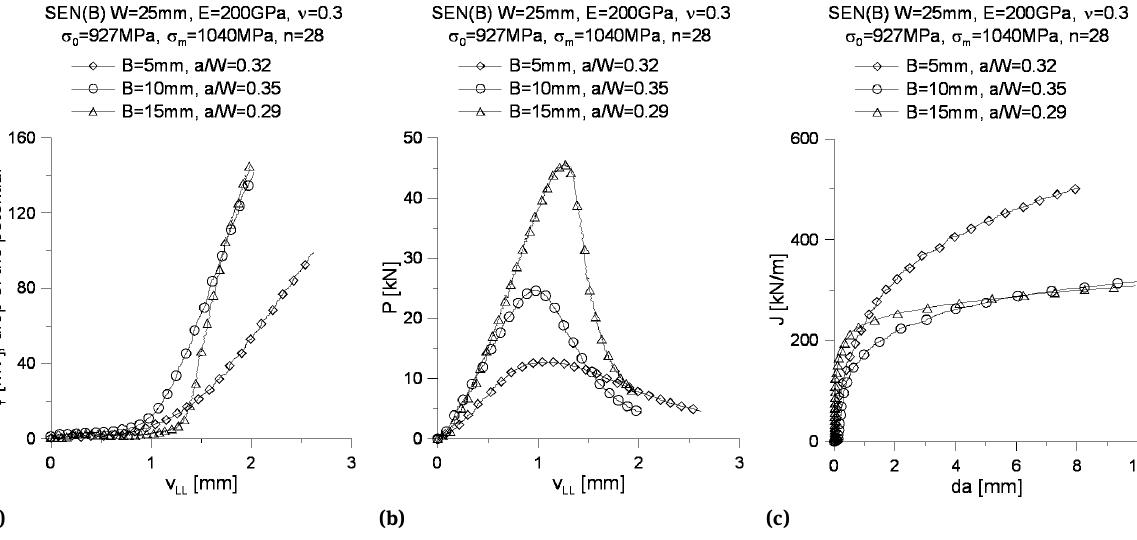
Figure 2: The comparison of the signals (quantities) of: a) potential drop φ in the function of the load line displacement v LL ; b) force P in the function of the load line displacement v LL ; c) J -integral (determined based on laboratory tests) as a function of the increase of the crack length da ; for three SEN(B) specimens made of 145Cr6 steel; (based on